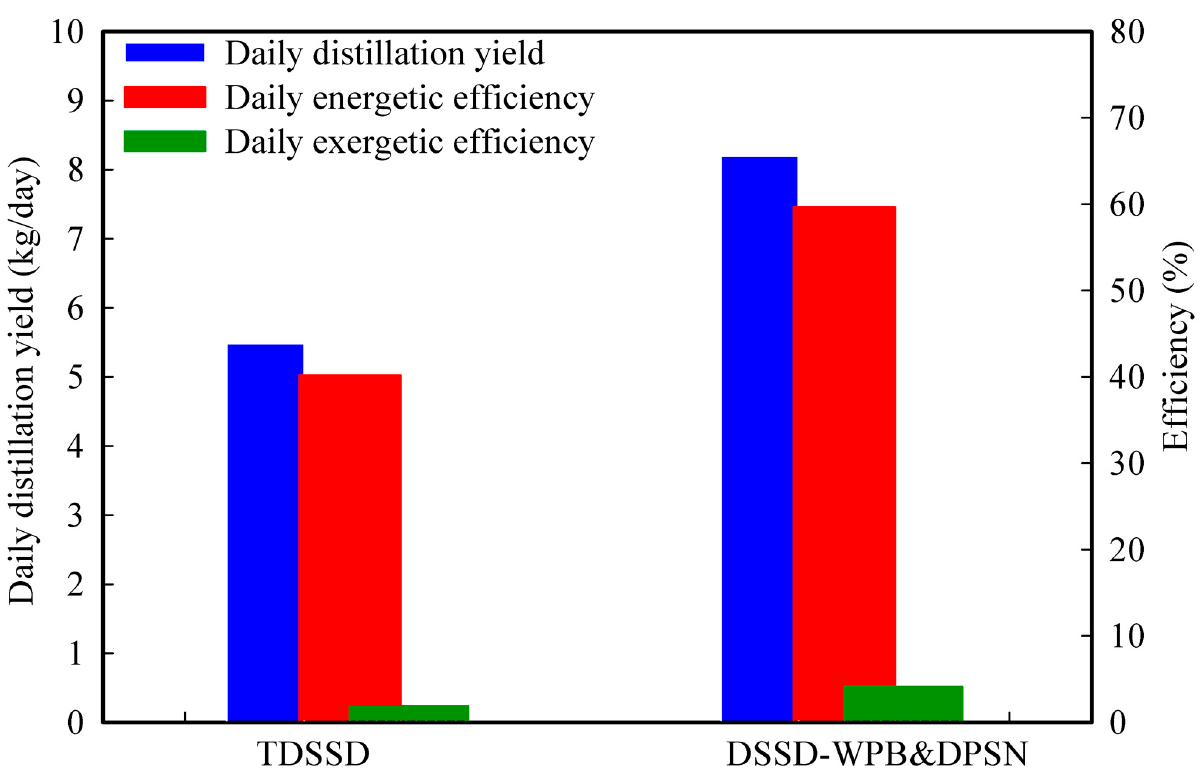
Figure 8. Comparison of the cumulative distillation yield, energy daily efficiency, and exergy daily efficiency of the DSSD-WPB&DPSN and TDSSD.